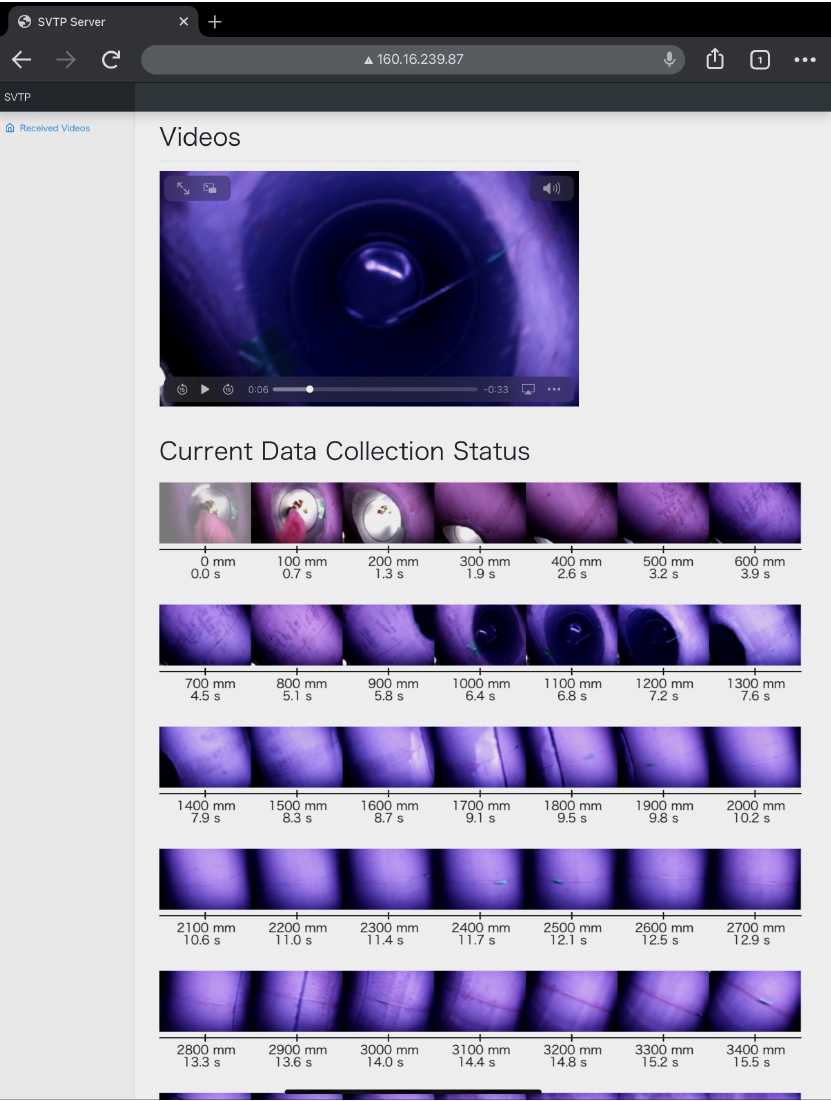
Figure 11. Web page for comparing the video frames and the captured position (displaying a result of the first trial